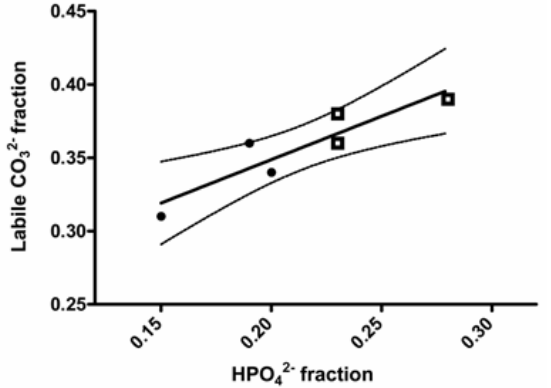
FIGURE 3. Linear relationship between labile carbonate and acid phosphate content of homogenized bone samples. The curves represent the 95% confidence band of the best fit line (● Male, □